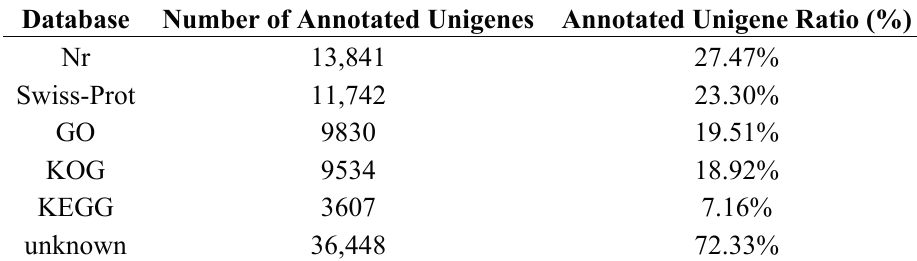
Table 2. Annotation of unigenes BLAST against five different